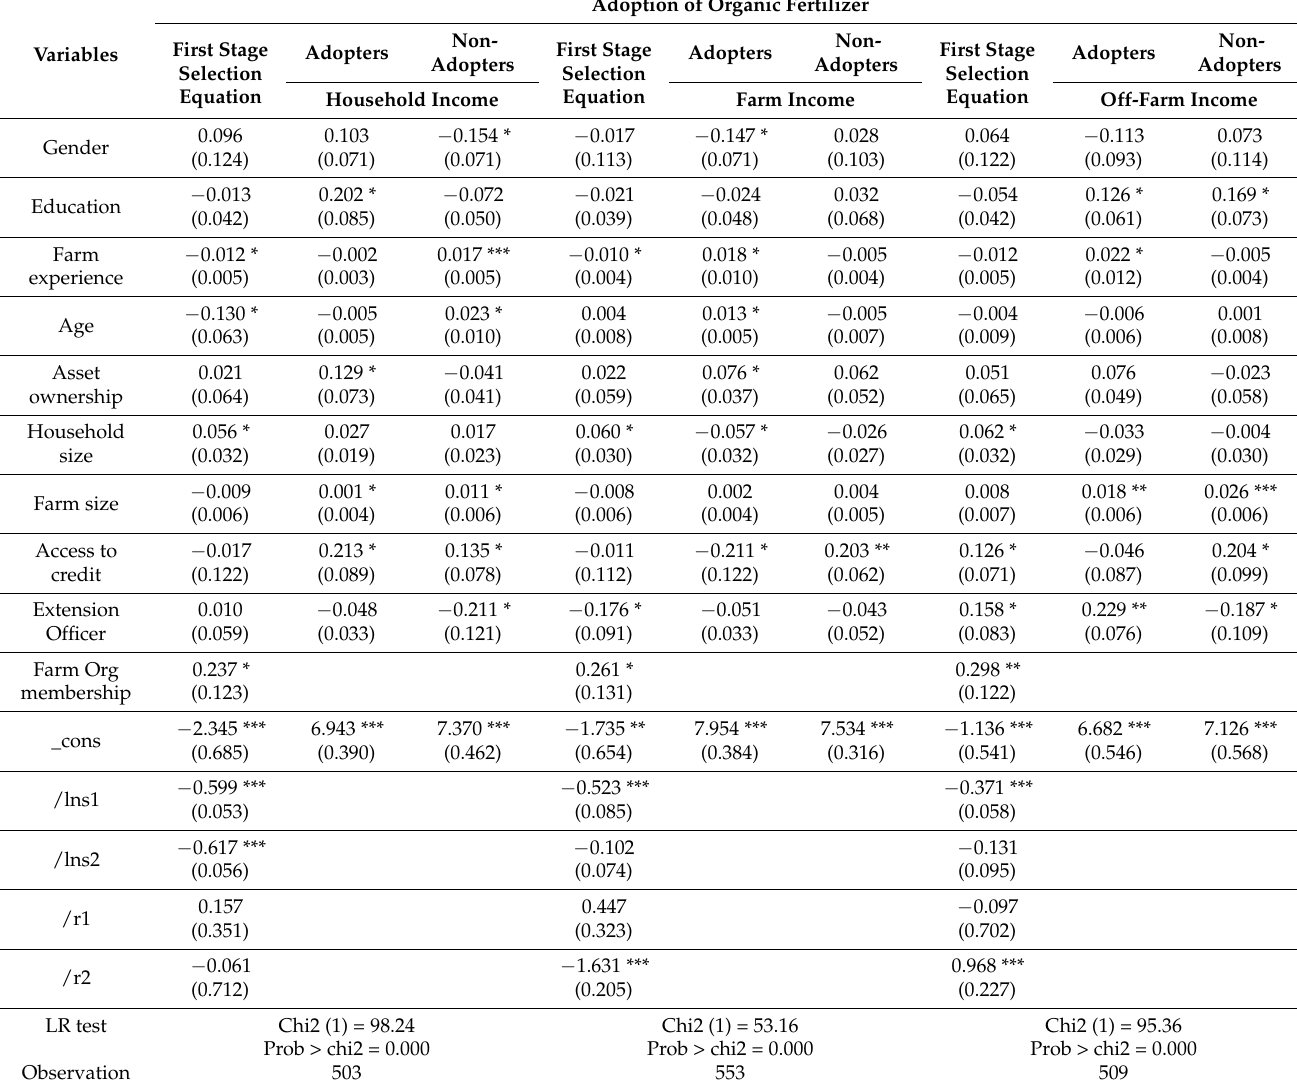
Table 8. Endogenous switch regression model estimation on adoption of organic fertilizer on income levels of cocoa